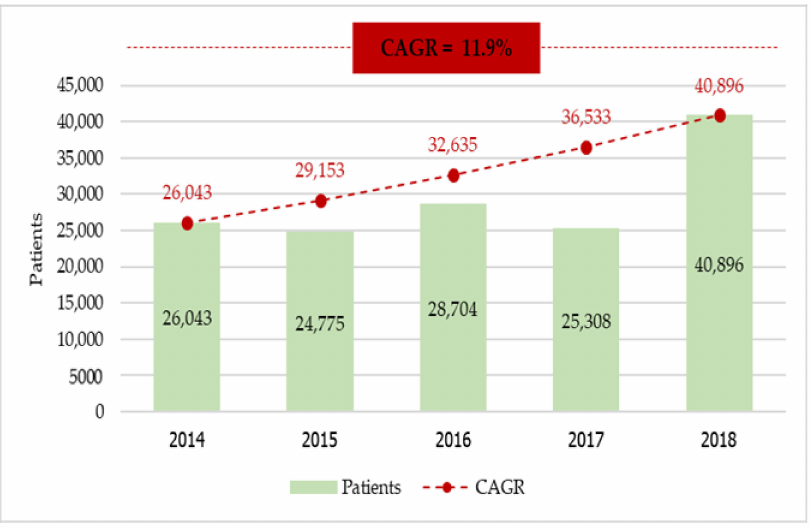
Figure 1. Number of expatriate outpatients in public hospitals in Thailand during